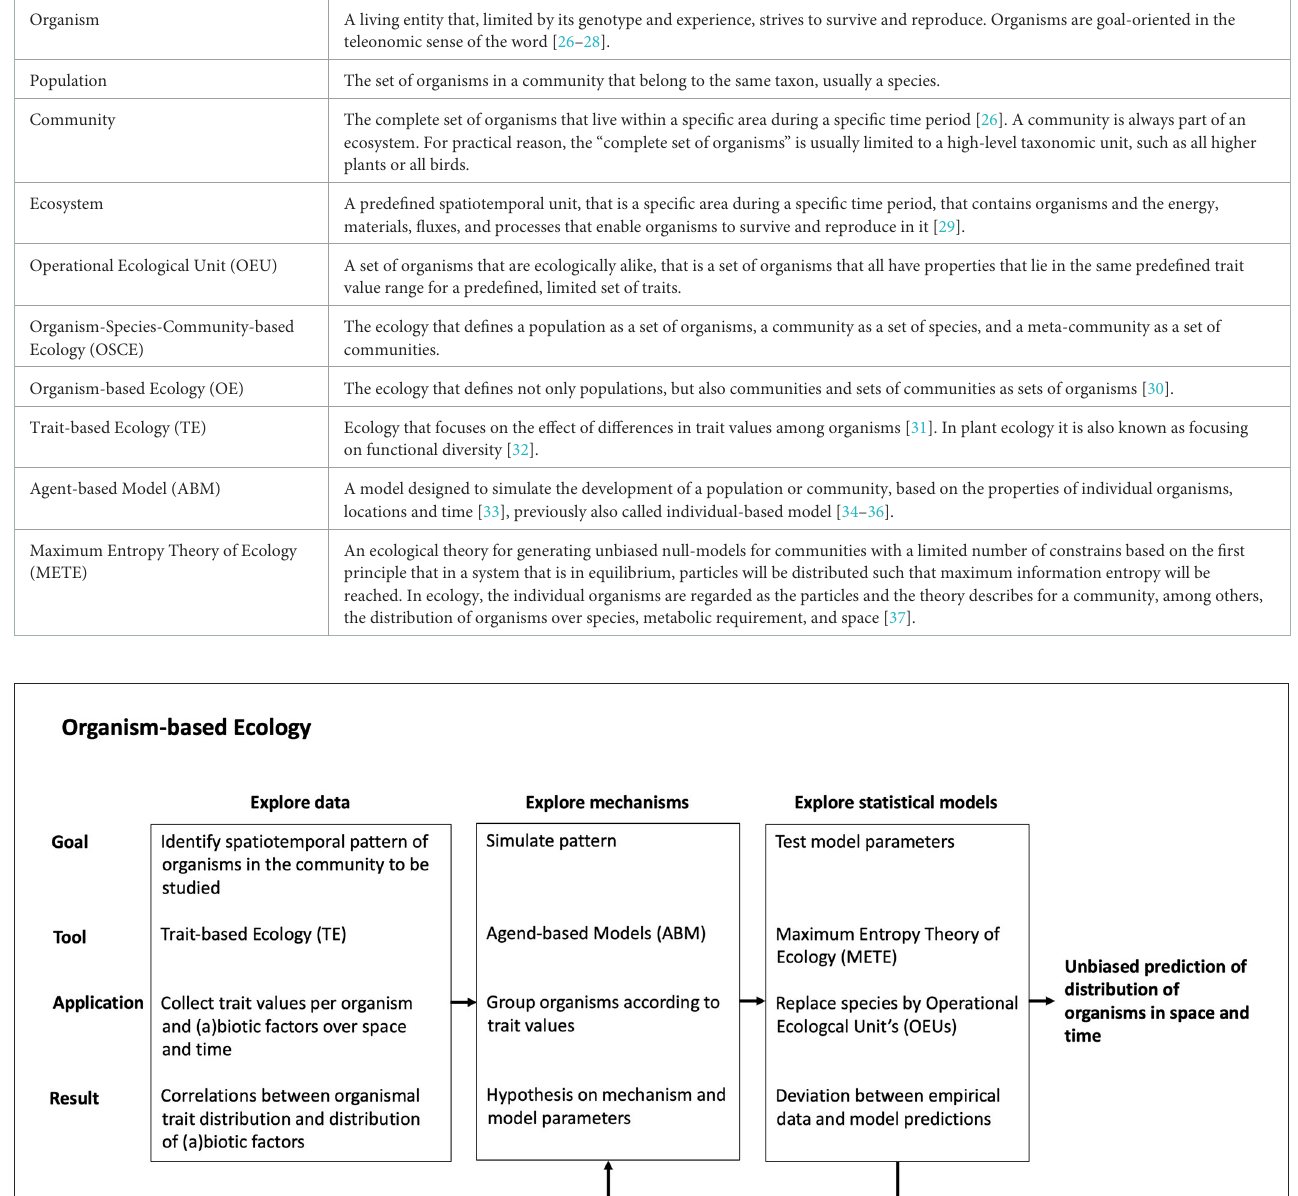
TABLE 1 Glossary of the key concepts.